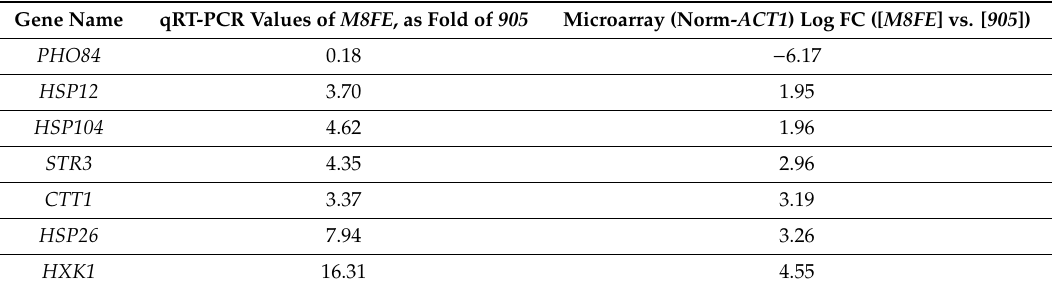
Table 4. qRT-PCR values of M8FE as fold of the reference strain 905 and the corresponding microarray results normalized to ACT1 as the log fold change of 905 for each selected